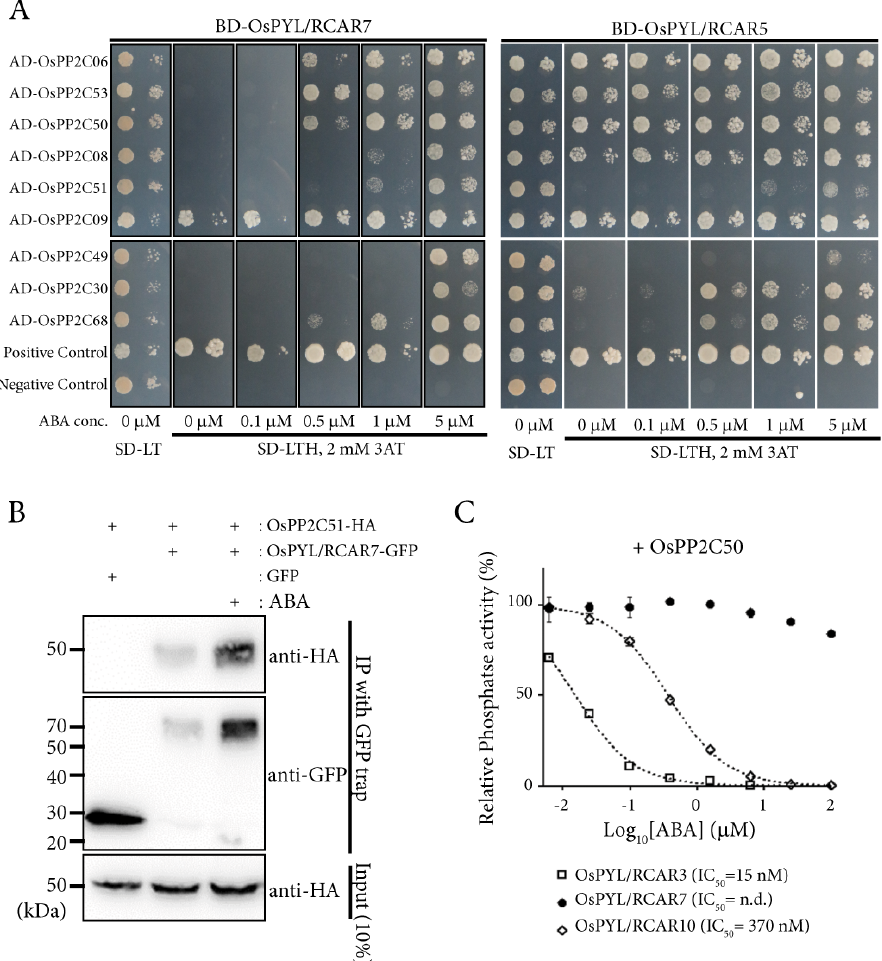
Figure 5. OsPYL / RCAR7 has stringent ABA dependency to interact with OsPP2CAs. ( A ) Yeast two hybrid analysis using OsPYL / RCAR7 and OsPYL / RCAR5 as baits and OsPP2CAs as preys. Synthetic minimal medium lacking leucine, tryptophan, and histidine (SD-LTH) supplemented with 0 to 5 µ M concentration of ABA were used. Photographs were taken 5 days after inoculation of transformed yeasts. ( B ) OsPYL / RCAR7-GFP (green fluorescent protein) was immunoprecipiated and co-immunoprecipiated OsPP2C51 was detected by human influenza hemagglutinin (HA) antibody. ( C ) Inhibition assay of phosphatase activity for OsPPC50 was performed by three ABA receptors (OsPYL / RCAR3, 7, and 10).